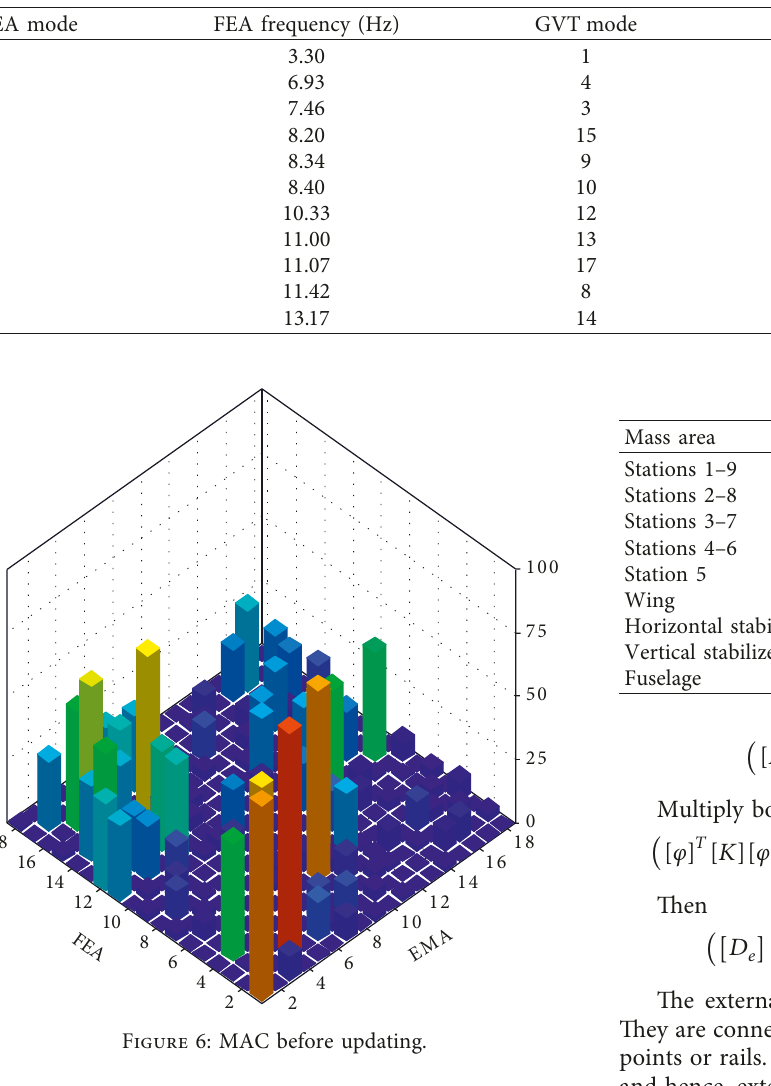
Table 3: Correlation data before model updating.